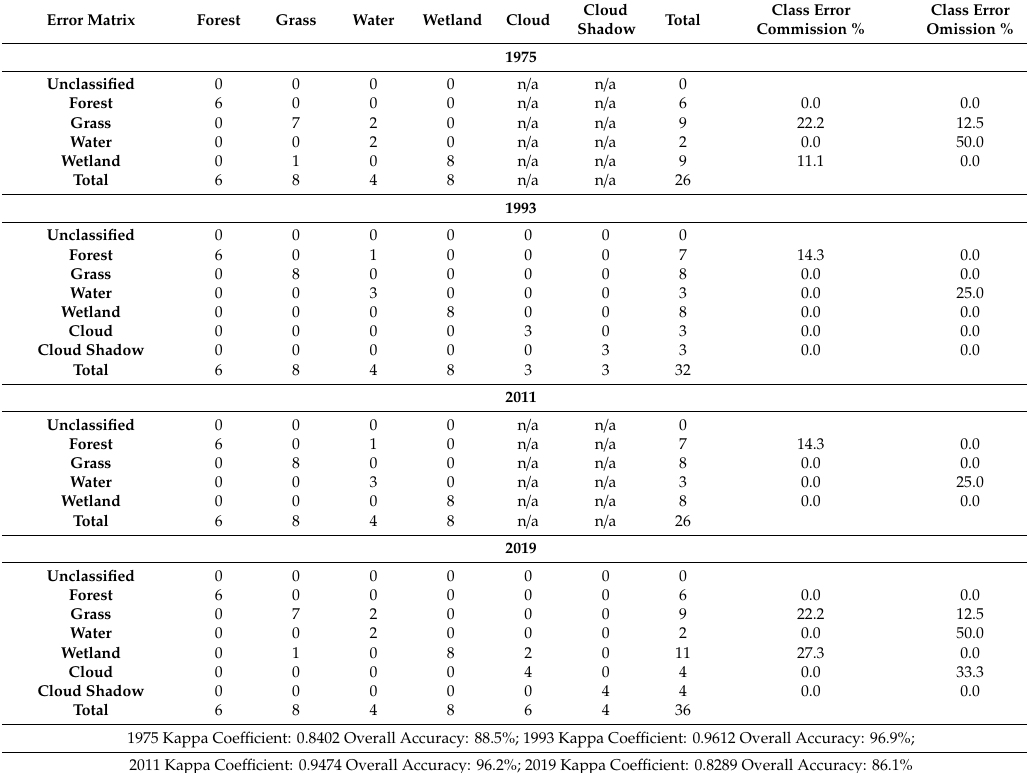
Table 1. Error matrices for Support Vector Machine classification results based on Landsat imagery and other data for 1975, 1993, 2011 and 2019. The 1975 and 2011 images were completely cloud-free. Error